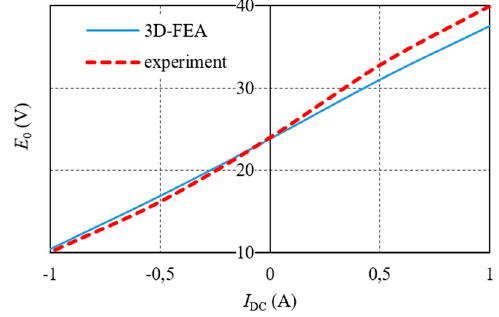
Figure 15. Experimental and 3D-FEA results of back-EMF characteristics versus DC control coil current. Waveforms of induced voltages at selected values of I DC currents are shown in Figure Table 2. Comparison of 3D-FEA predictions and experimental results of no-load back-emf (RMS).